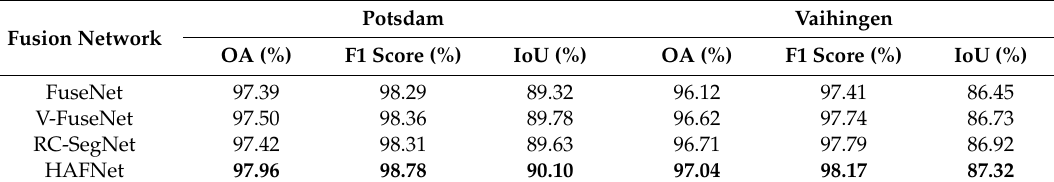
Table 6. Quantitative results of FuseNet, V-FuseNet, RC-SegNet, and HAFNet.